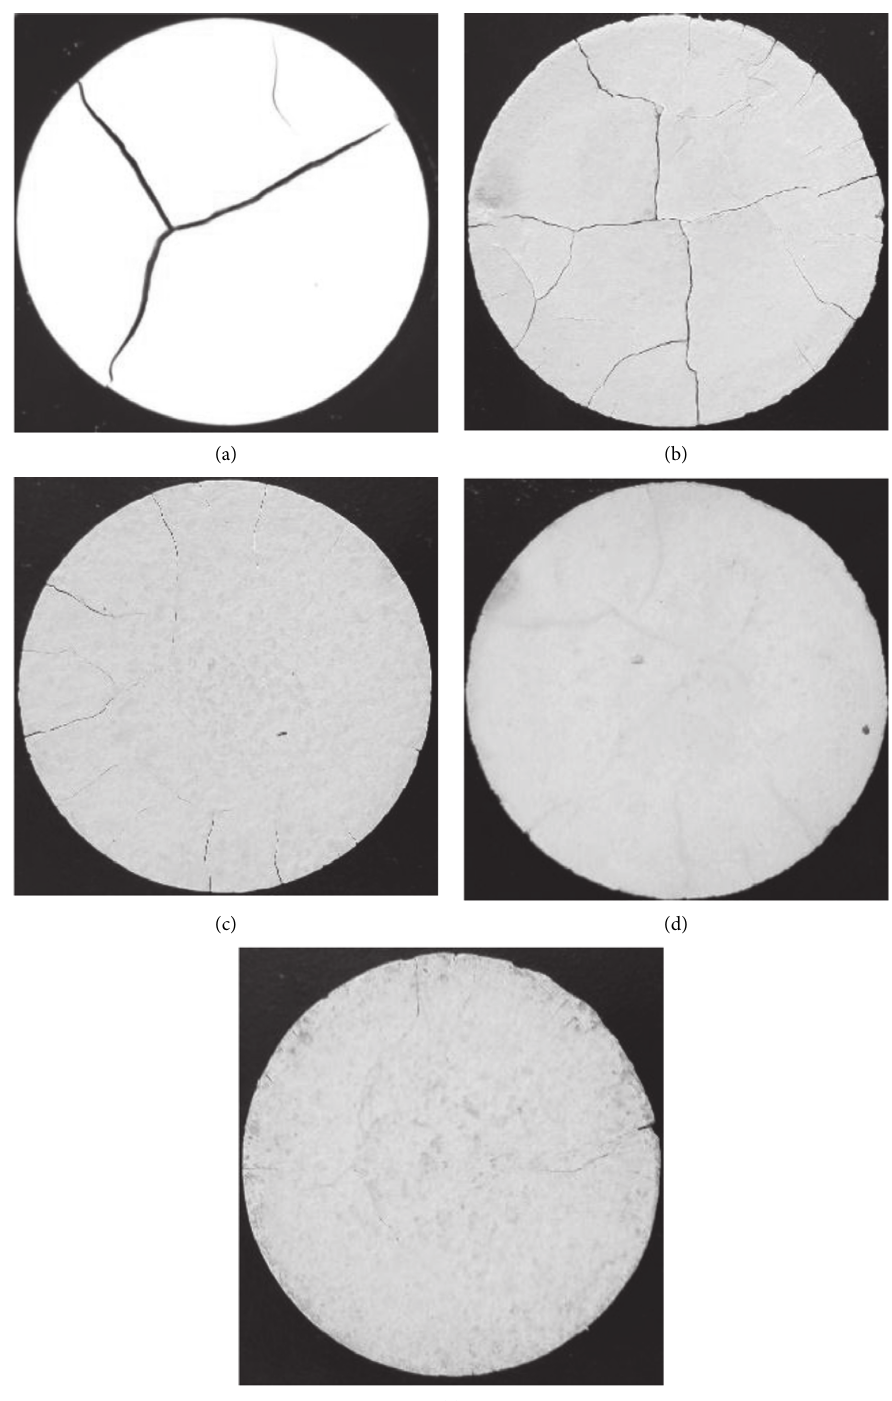
Figure 7: Images of specimens at the completion of the drying test: (a) DW, (b) 0.5Na-T, (c) 0.5Ca-T, (d) 2.0Na-T, and (e)